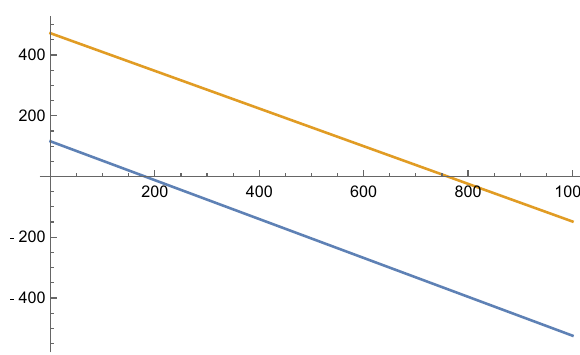
Fig. 12 Equation of state in terms of temperature with G = m = k = 1, and λ = 3. The blue line corresponds to N = 10 and the brown one to N = 15 The allowed physical temperatures are those for